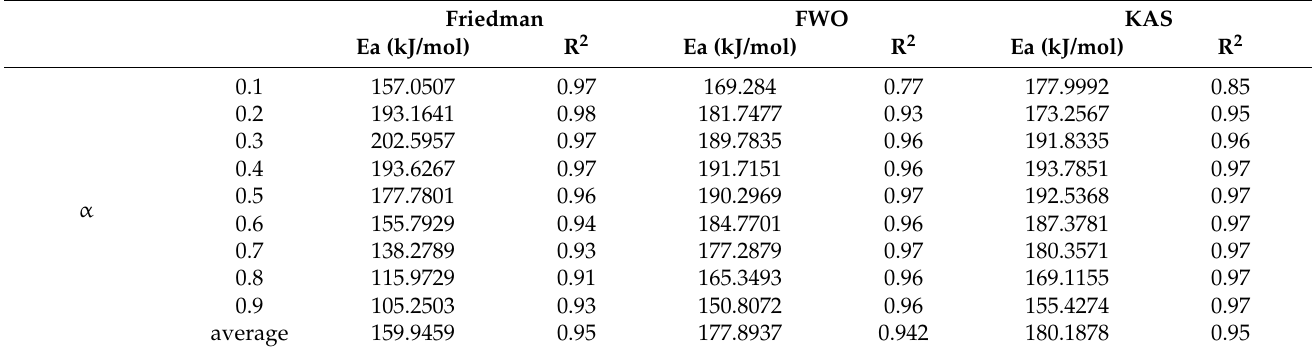
Figure 9. Ea and R 2 of three model-free methods in the second stage of battery material pyrolysis. Table 3. Ea and R 2 of three model-free methods at different conversion rates in the third stage of pyrolysis kinetics of battery